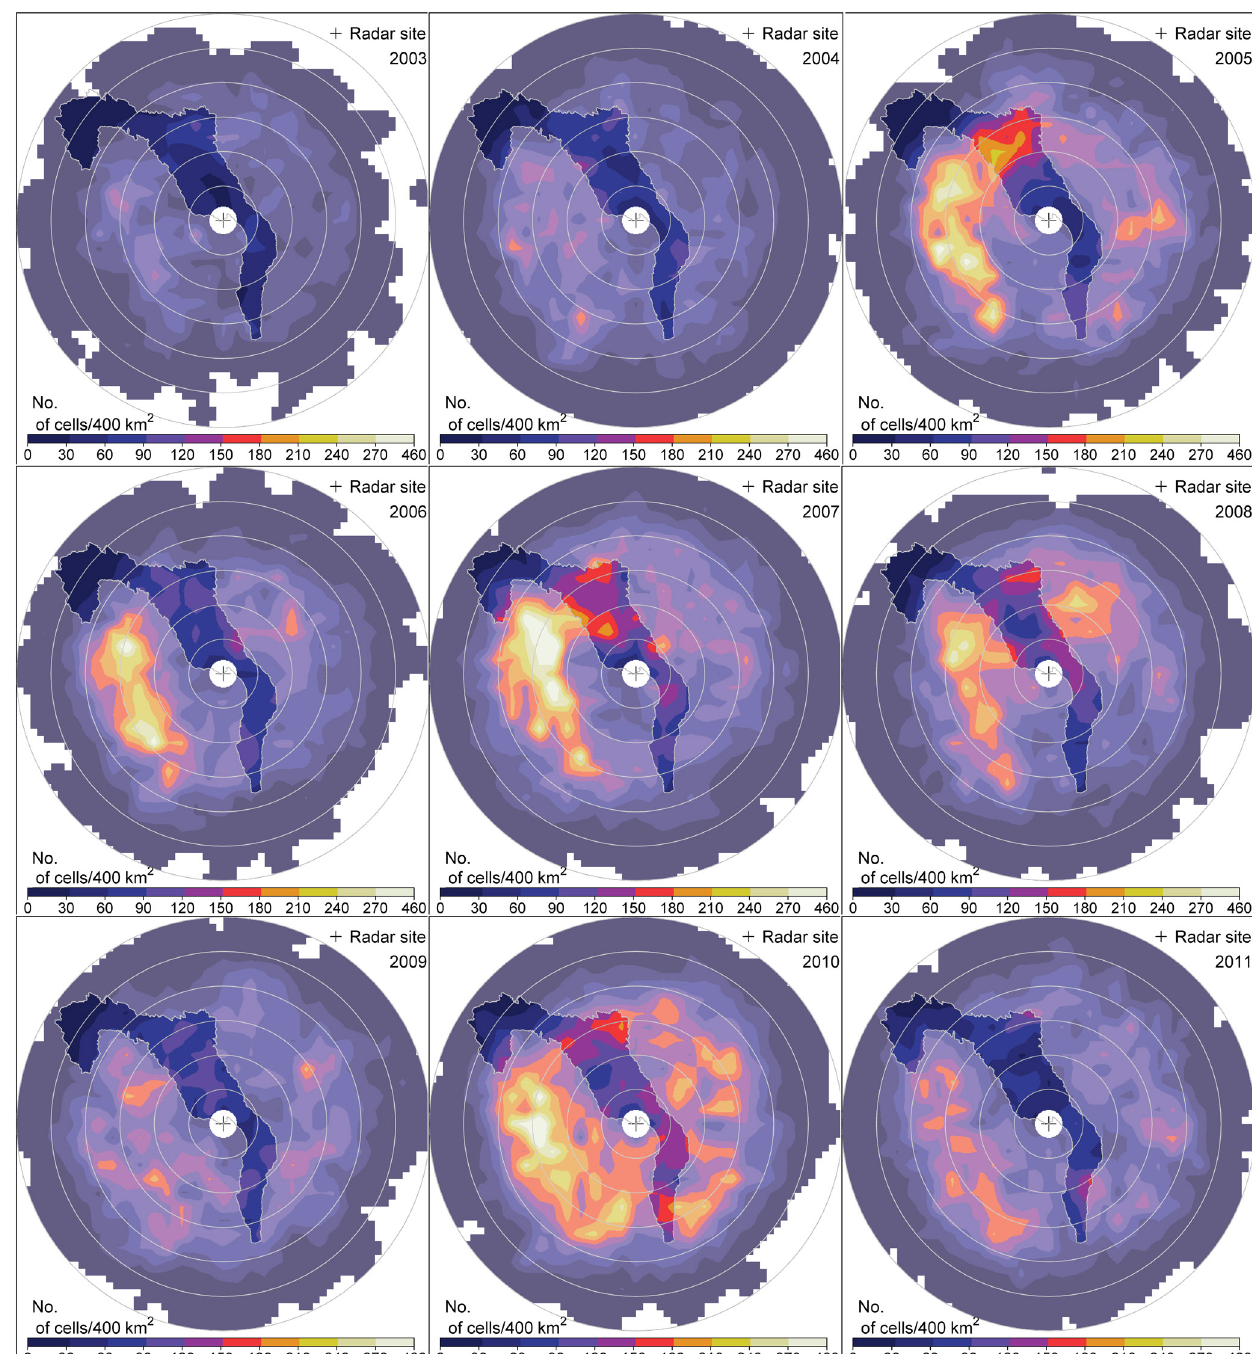
Figure 6. Spatial distribution of the convective storm cells in the study area, for the period May–August, for each year between 2003 and 2011. The year is denoted in the upper right corner of each panel, starting from top to bottom and from left to